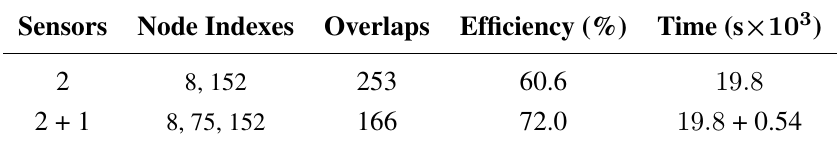
Table 2. Sensor placement in the Limassol network using the semi-exhaustive